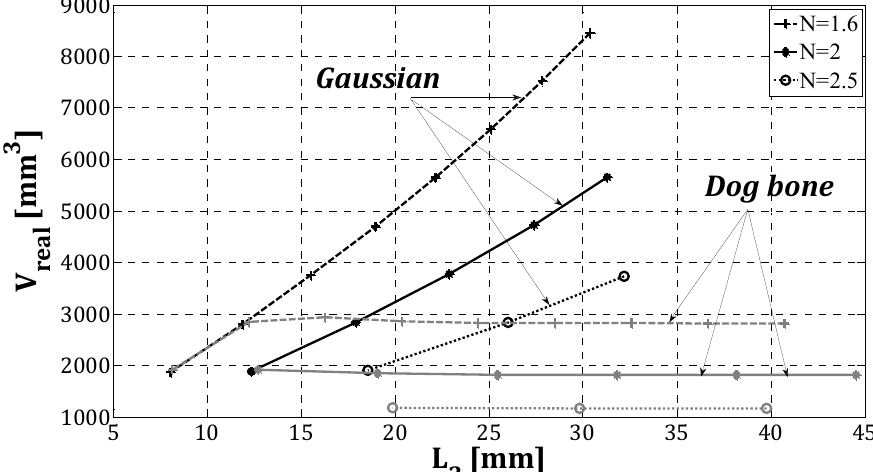
V of dog-bone and Gaussian specimens with respect to the length Figure 3: real